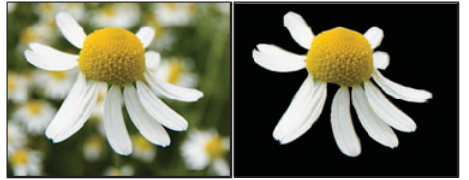
Figure 19: Original (left) and segmented (right) image of chamomile (Source: Miller,